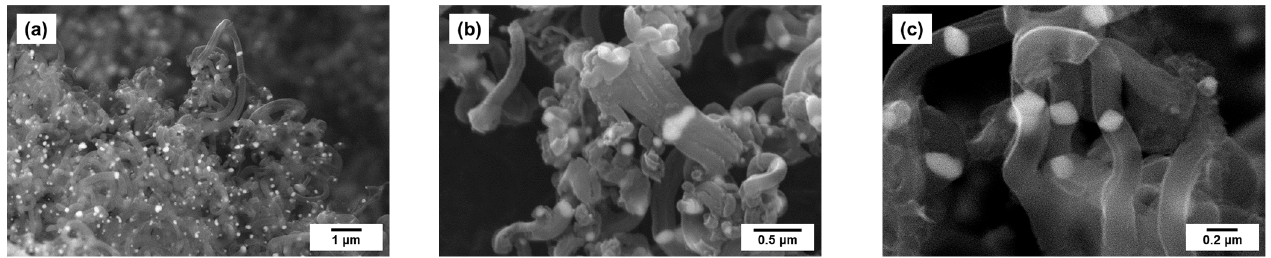
Figure 6. SEM images (back-scattered electron beam mode) of Pt 0.50 Ni 0.50 /CNF composite obtained via ethylene decomposition at 600 ◦ C for 15 min (Y CNF = 3.6 g/g cat ): ( a ) 10,000 × ; ( b ) 30,000 × ; ( c ) 60,000 ×